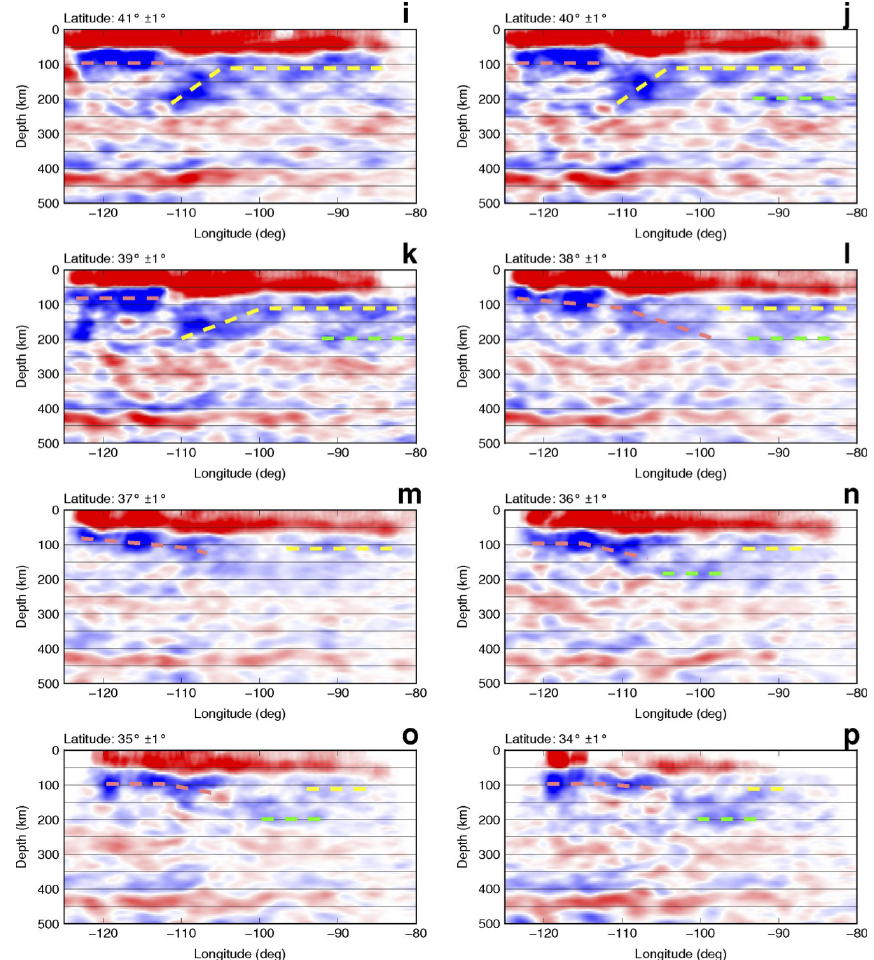
Figure 8. Depth-migrated west–east S-receiver function profiles (see location map at the top of the figure). The width of each profile is 2 ◦ latitude with 1 ◦ overlap. The latitude of the profiles is marked at each profile. The magenta dashed line is interpreted as the LAB of the Farallon plate, the yellow dashed line as the MLD and the green dashed line as the LAB of the Laurentia plate, respectively. The dashed black line is a low-velocity zone above the 410 discontinuity. See text for a discussion of these